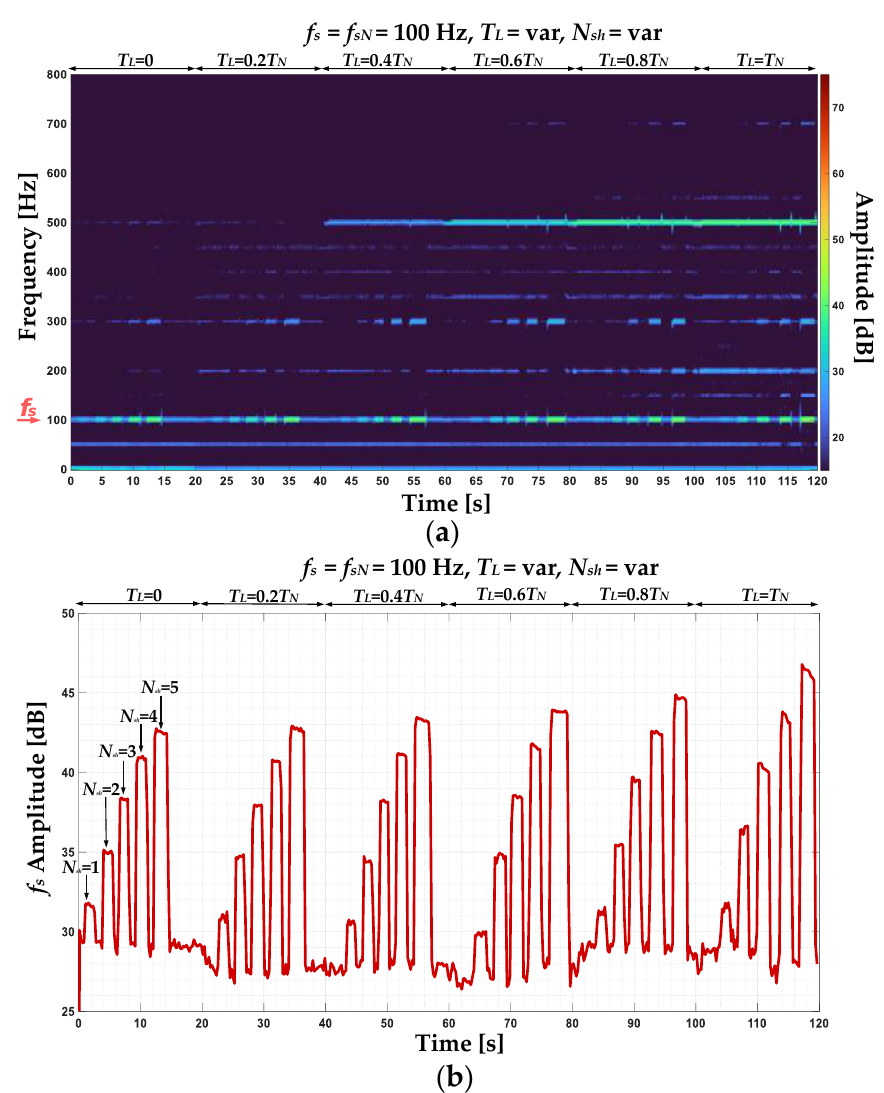
Figure 10. The stator phase currents negative sequence component ( a ) STFT spectrogram and ( b ) f s amplitude changes during the online operation of the drive system cyclic momentary short-circuiting of 1 to 5 turns at variable load torques.